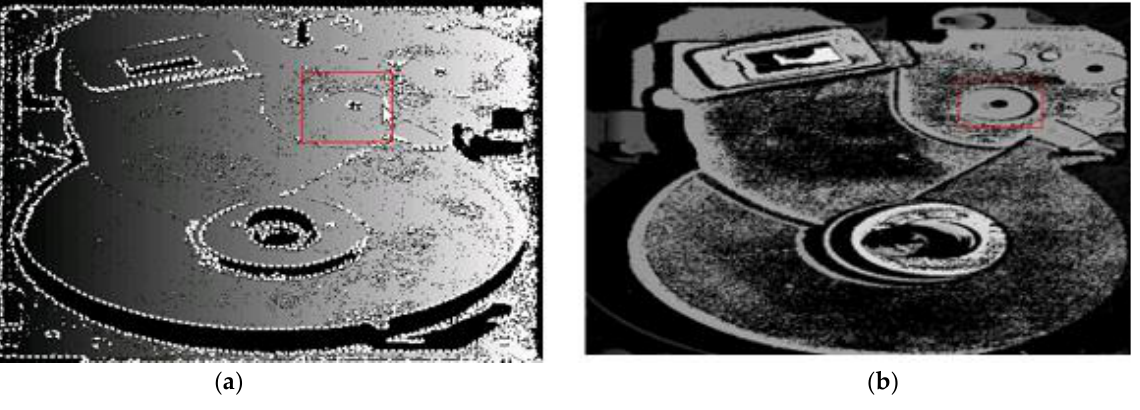
Figure 12. Strip center extraction and performance comparison of the roller: ( a ) strip center after the Steger method; ( b ) v = 0.7 order differential enhancement; ( c ) performance comparison of extracting the stripe center; ( d ) from dark background stripe image.